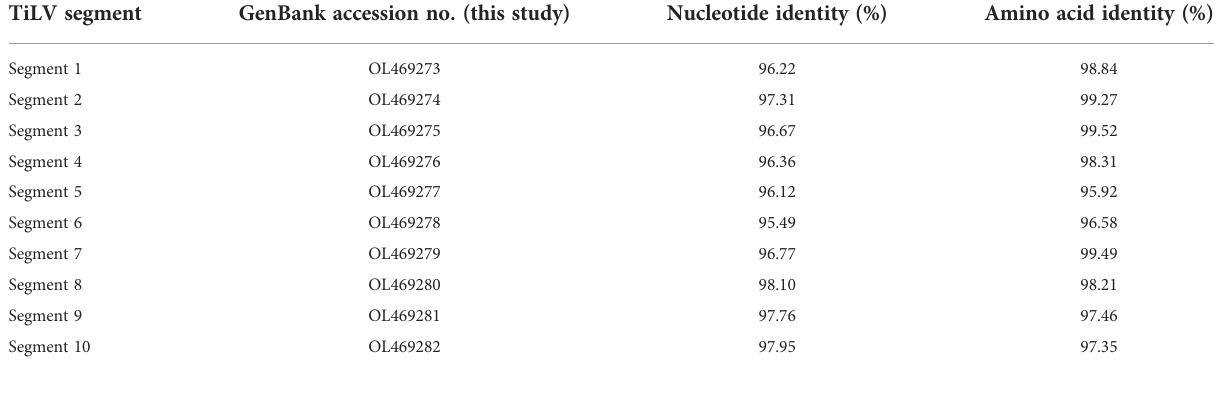
TABLE 2 Nucleotide and amino acid identity of coding region of TiLV segments 1-10 in this study and the original TiLV isolate from Israel. TiLV segment GenBank accession no. (this